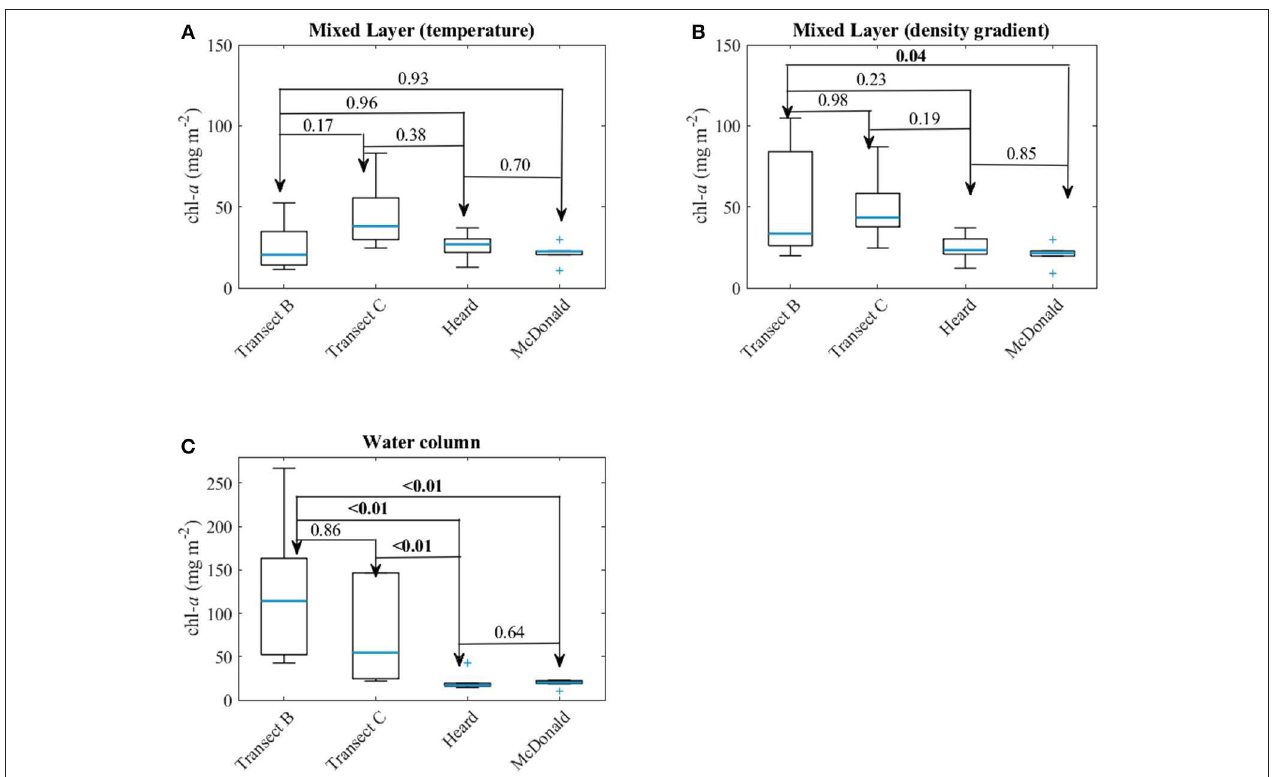
FIGURE 7 | Chlorophyll a (chl- a ) inventories (A) in the mixed layer calculated using the temperature criterion, (B) using the density gradient criterion, and (C) within the entire water column. The blue lines indicate the median and the box represents the range between 25 and 75% quartile and the whiskers correspond to ± 2.7 standard deviation (99.3% of data if normally distributed). The numbers given are the p -values for the Kruskal-Wallis test. Numbers in bold indicate statistically significant differences.